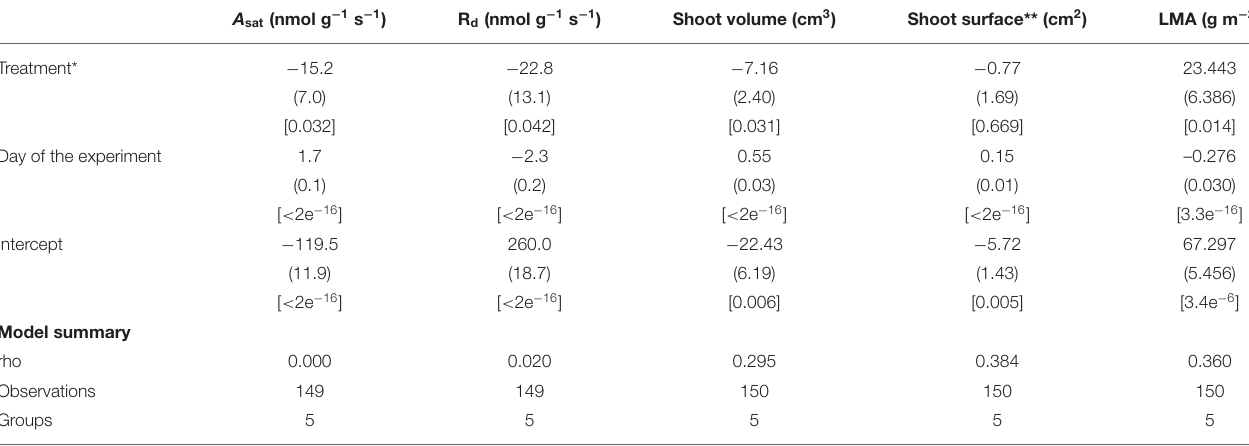
TABLE 1 | Effects of time and drought on A sat , R d and shoot deployment.